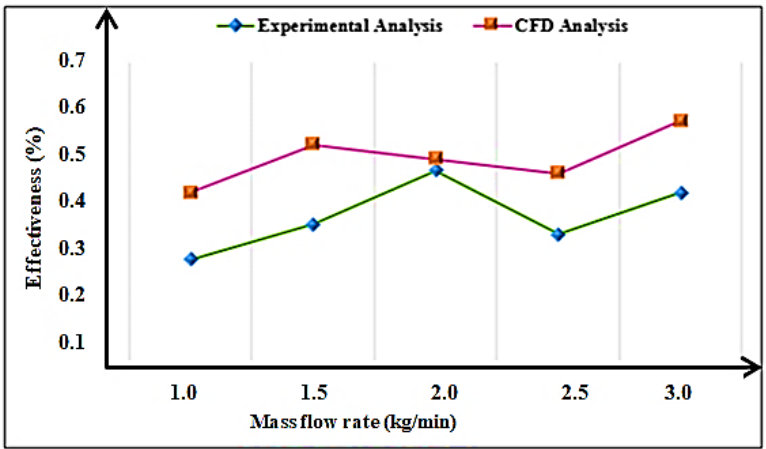
Figure 12 . Effectiveness of the absorber plate and tube.